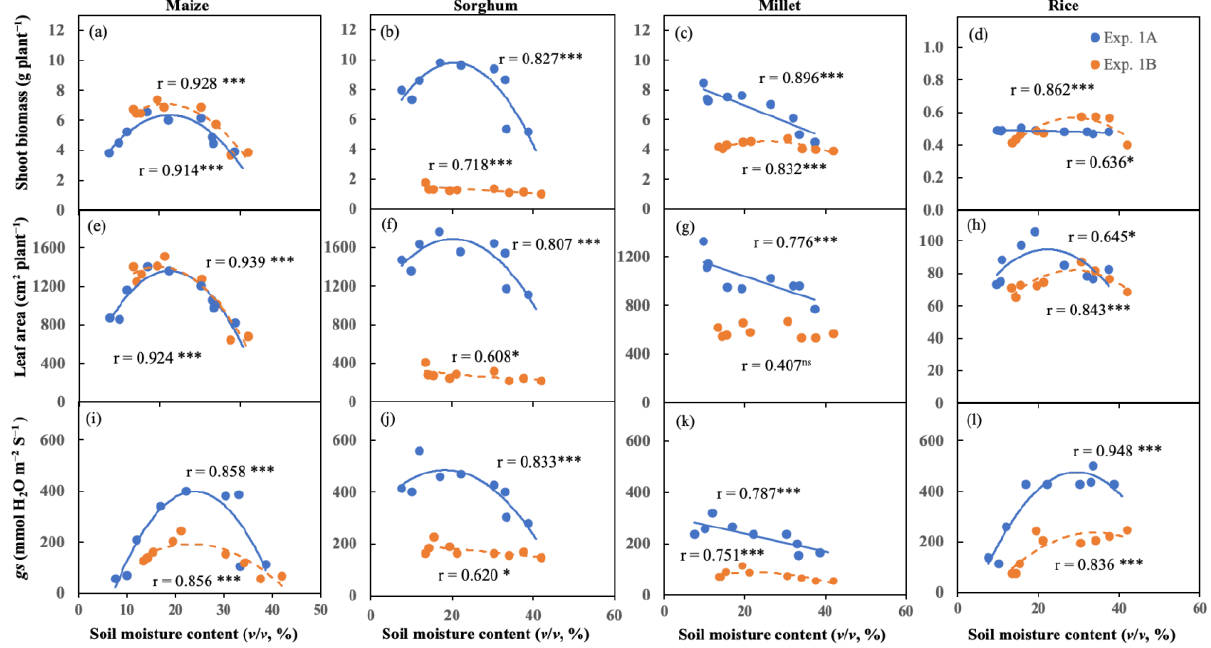
Figure 2. Correlations between soil moisture content and shoot biomass ( a – d ), leaf area ( e – h ), and stomatal conductance ( gs ; i – l ) in maize ( a , e , i ), sorghum ( b , f , j ), millet ( c , g , k ), and rice ( d , h , l ). *, ***, and ns indicate Pearson statistical significance at p < 0.05, p < 0.001, and non-significance, respectively ( n = 9). Linear or nonlinear (polynomial) correlation line is decided by coefficient.